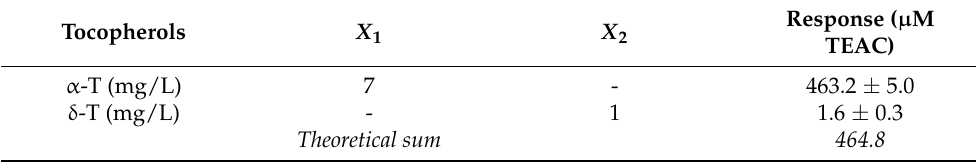
Table 2. DPPH assay for individual tocopherols.